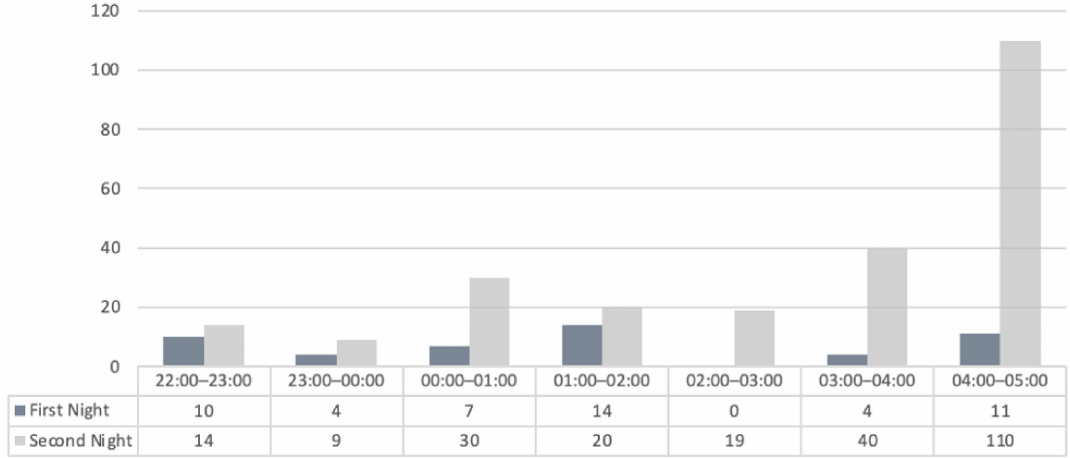
Figure 10. Number of events with L Aeq > 45 dB(A) during the first and second night.